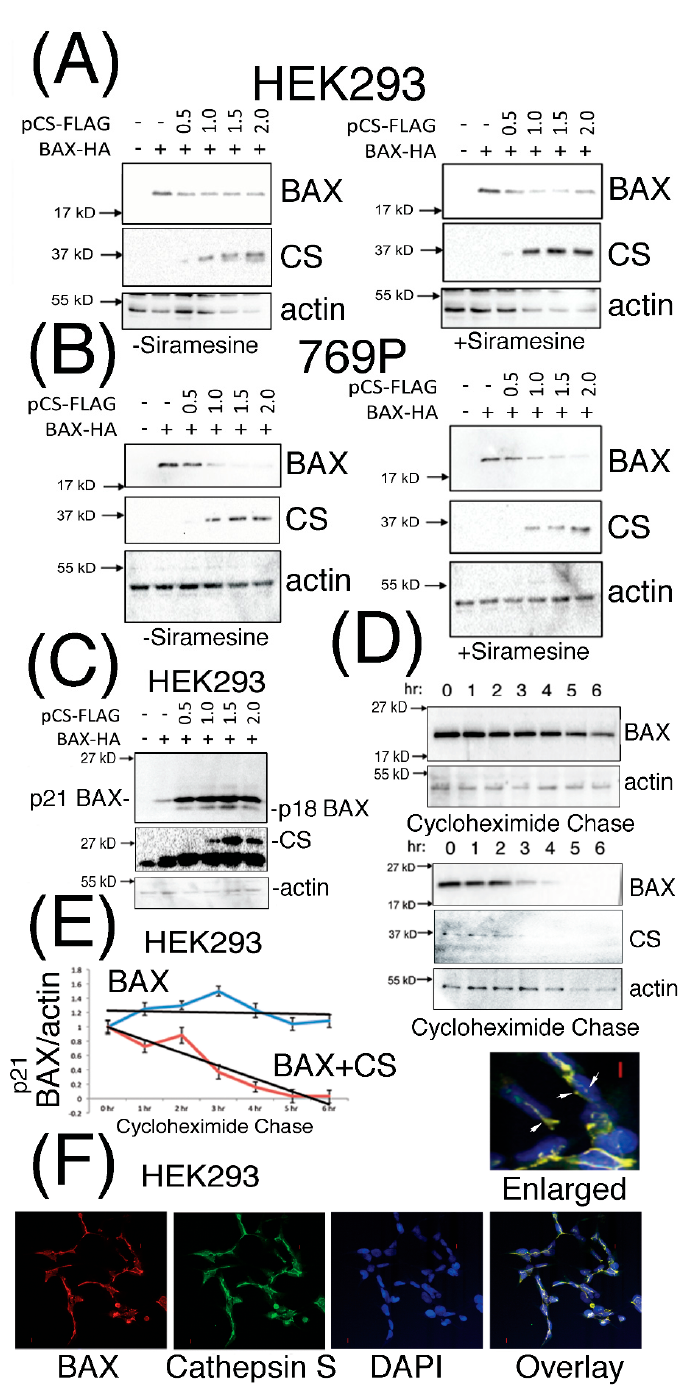
Figure 2. CS expression can destabilize the p21 BAX protein and co-localize with it in distinct cytoplasmic and peri-nuclear compartments. (Panels A and B ), HEK293 and 769P cells were co-transfected with pBAX-HA and increasing doses of pCS-FLAG ( μ g) expression plasmids for 24 h, stimulated with carrier (left panels) or 2 μ M Siramesine (right panels) for 1 h and equal volumes of soluble cell extracts analyzed for p21 BAX, CS and actin expression levels. (Panel C ), HEK293 cells